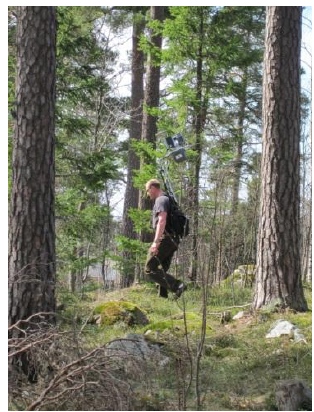
Figure 3. PLS measurement.